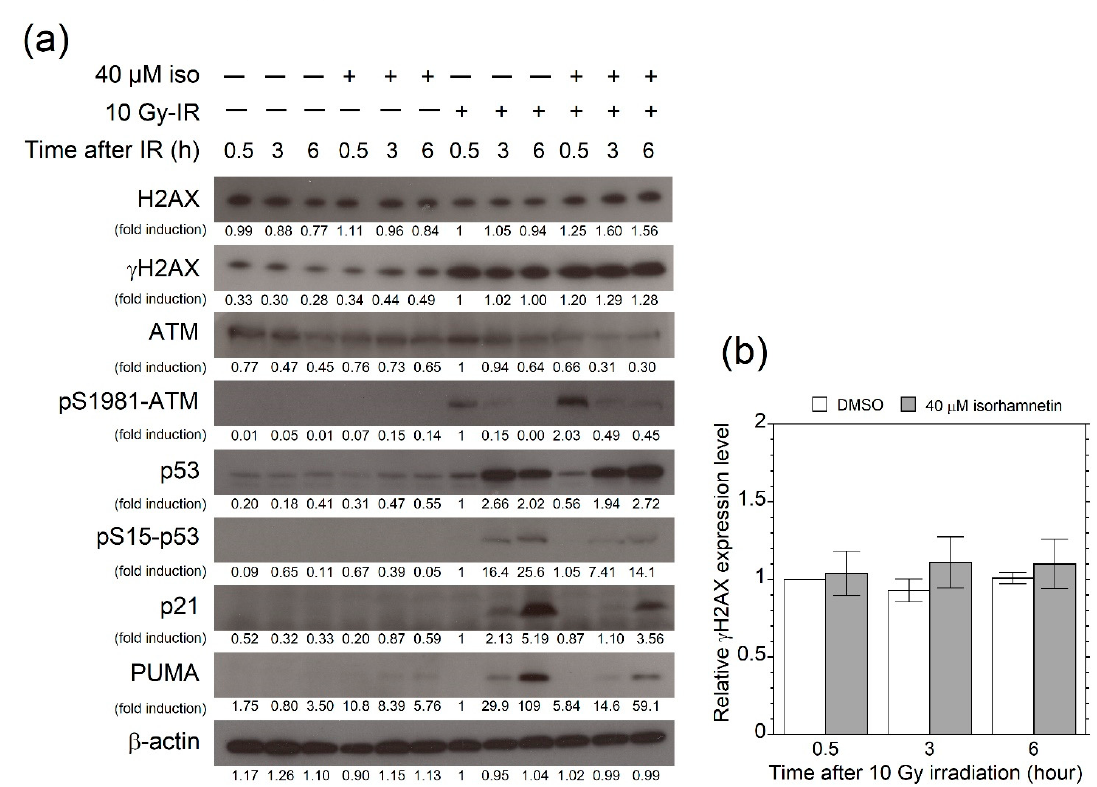
Figure 4. Isorhamnetin enhances ATM phosphorylation in irradiated MOLT-4 cells. ( a ) DNA damage response-related gene products were detected by Western blotting 0.5, 3, and 6 h after 10 Gy irradiation, and signal intensity of each band was analyzed by densitometry. The original value of each signal intensity ratio was determined using the signal intensity obtained from cells 0.5 h after 10 Gy irradiation (1.5 h after DMSO treatment) as a control (lane 7). The band intensity ratio of each sample was then normalized by the band intensity ratio of β -actin as an internal control. ( b ) Relative expression level of γ H2AX ( n = 3). Data represent the mean ± standard deviation. DMSO dimethyl sulfoxide, Iso isorhamnetin, IR irradiated.